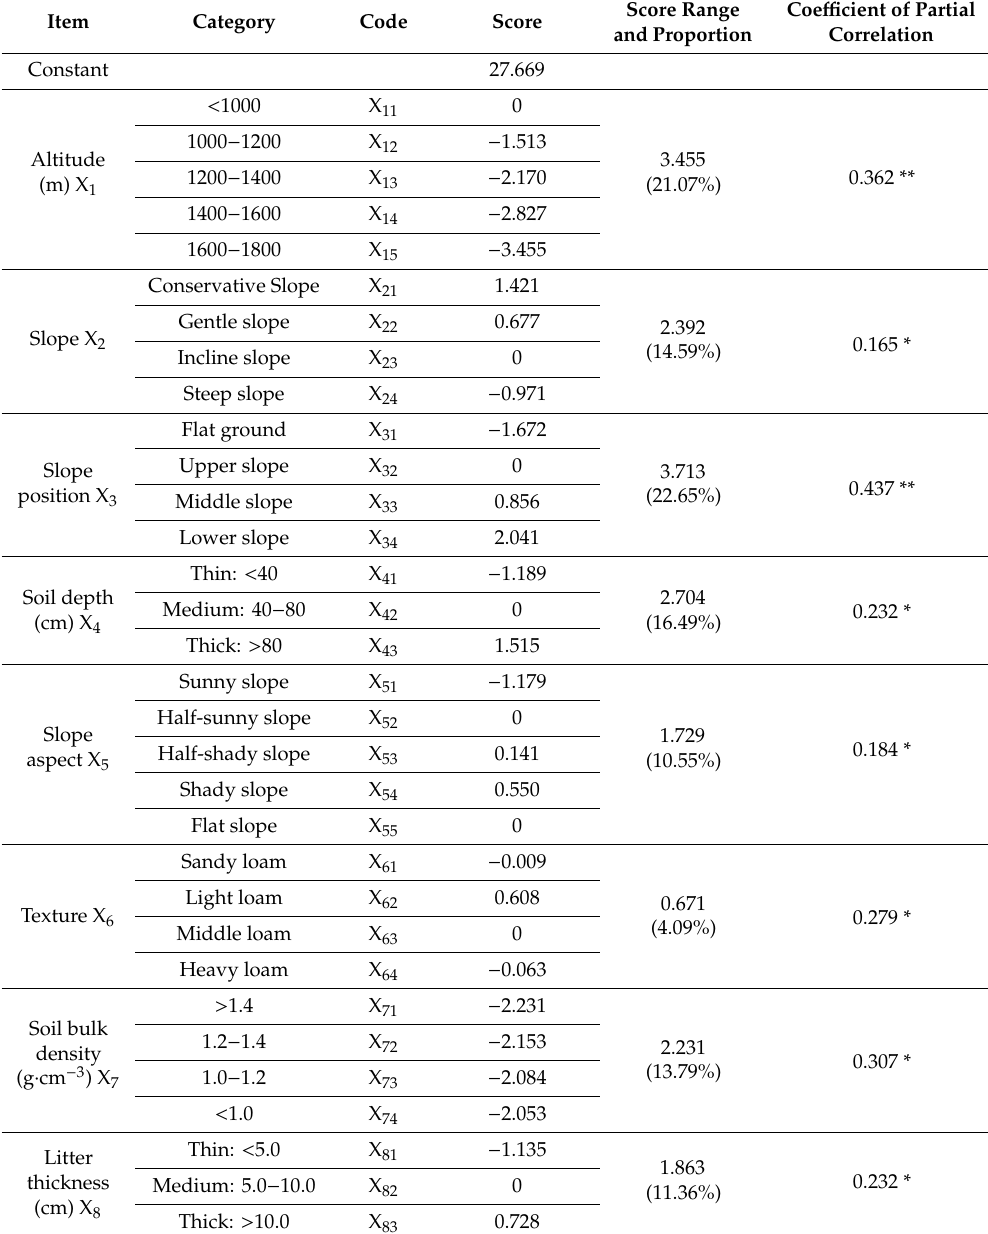
Table 3. Quantity regression result of site